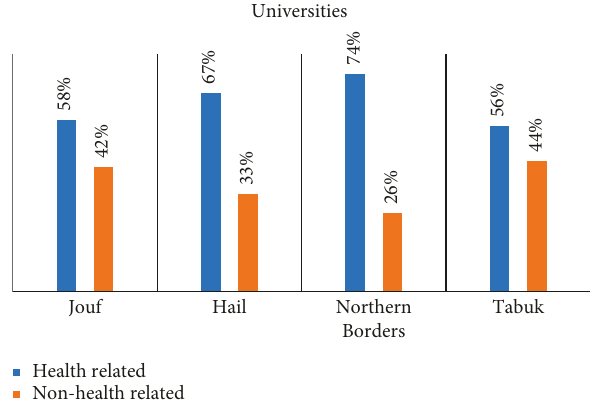
Figure 2: CPR knowledge between health- and non-health-related colleges for each university. Table 2: Knowledge of the participants about cardiopulmonary